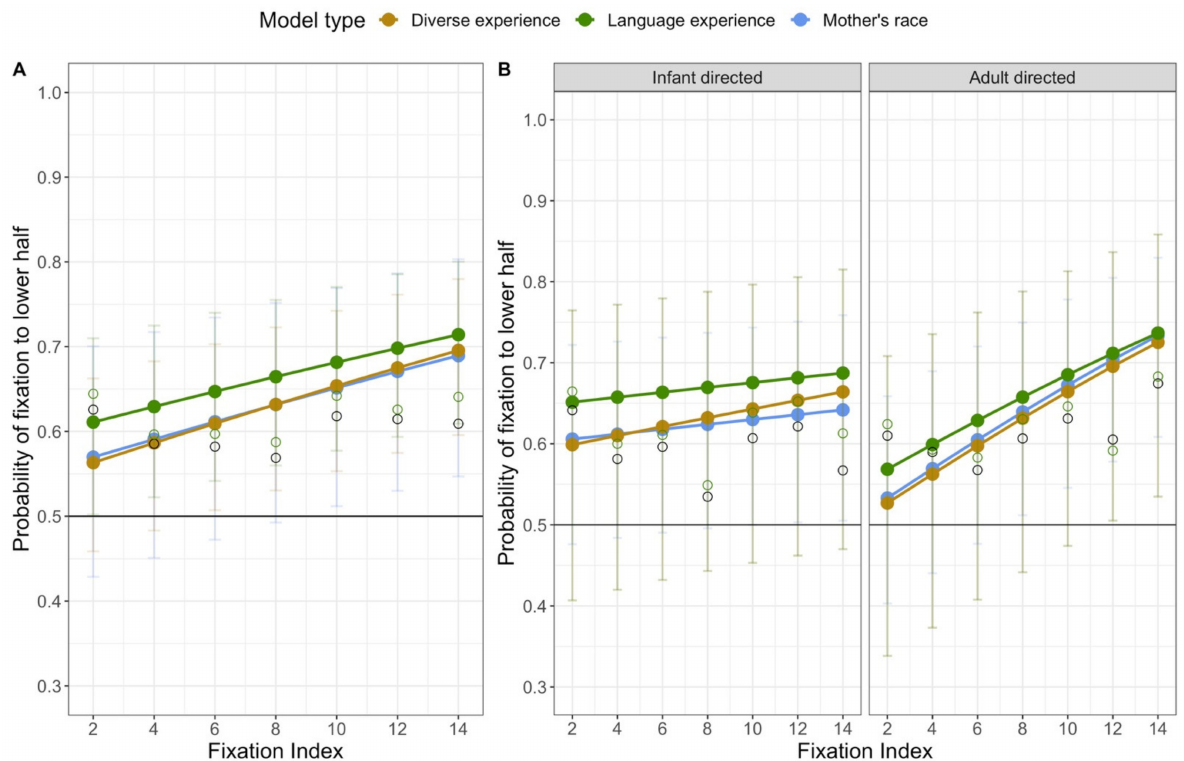
Figure 10. The probability of a fixation that is directed to the lower region of the face; higher numbers indicate a larger probability of fixations to the lower half: ( A ) depicts the fixed effect of Index, and shows how the probability of fixations to the lower half changes over fixation index. ( B ) depicts the interaction between speech type and fixation index and shows how the change in the probability of fixations directed to the lower half over fixation index is different for infant-directed and adult-directed stimuli. The line bisecting each figure at 0.50 indicates change (e.g., equal proportion of looking to the upper and lower halves). For each graph, the open circles represent the observed proportion of fixations directed to the lower half of the faces collapsed across all infants and for all trials; the green open circles only contain fixations from infants that were considered multilingual or monolingual and used for the language analyses, the black open circles represent fixations from all infants regardless of language experience. The filled circles connected by colored lines represent the marginal means from each of the models. The brown circles are the marginal means from the diversity of experience model, the green circles are from the language experience model, and the blue circles are from the mother’s race model. Error bars represent asymptotic upper and lower confidence